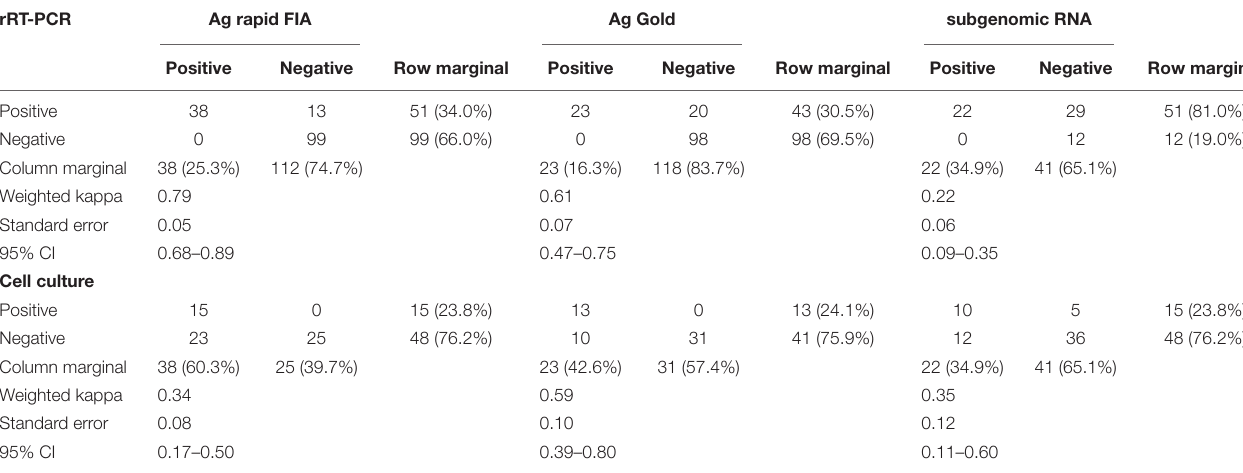
TABLE 2 | Evaluation of interrater agreement between two types of antigen test and subgenomic RNA with rRT-PCR (N-gene) and cell culture-based